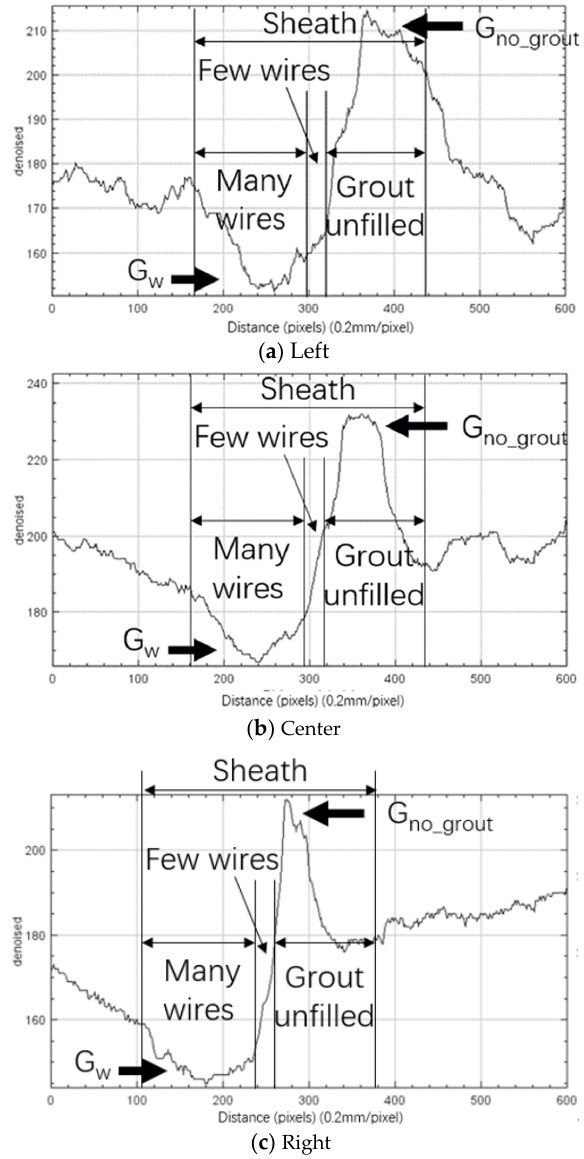
Figure 23. Line segments for gray value analysis for unfilled grout in the X-ray image of 200 mm thick WEB of the T-shape PC girder bridge by the 950 keV X-ray source.